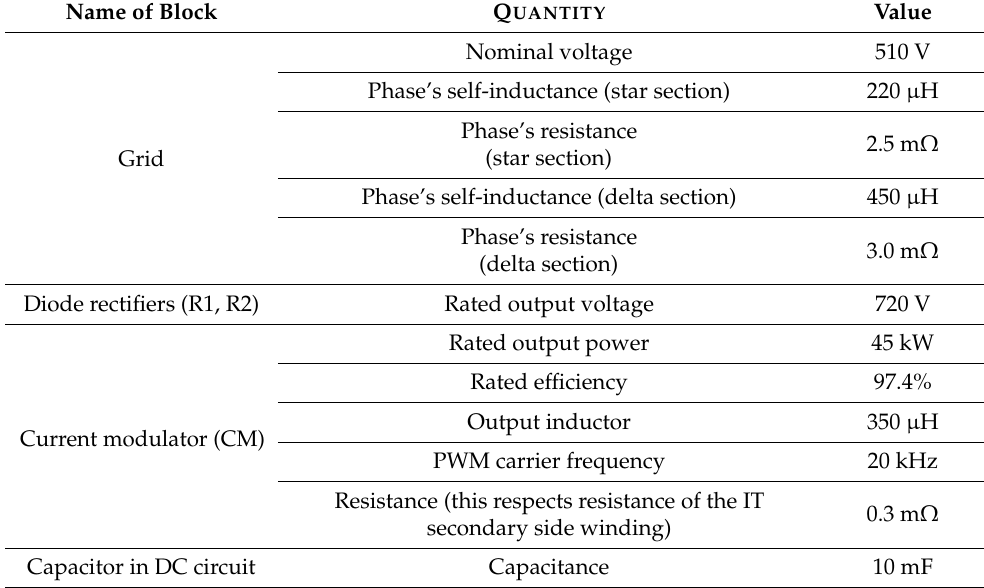
Table 1. Parameters of the diode rectifier with current modulator.